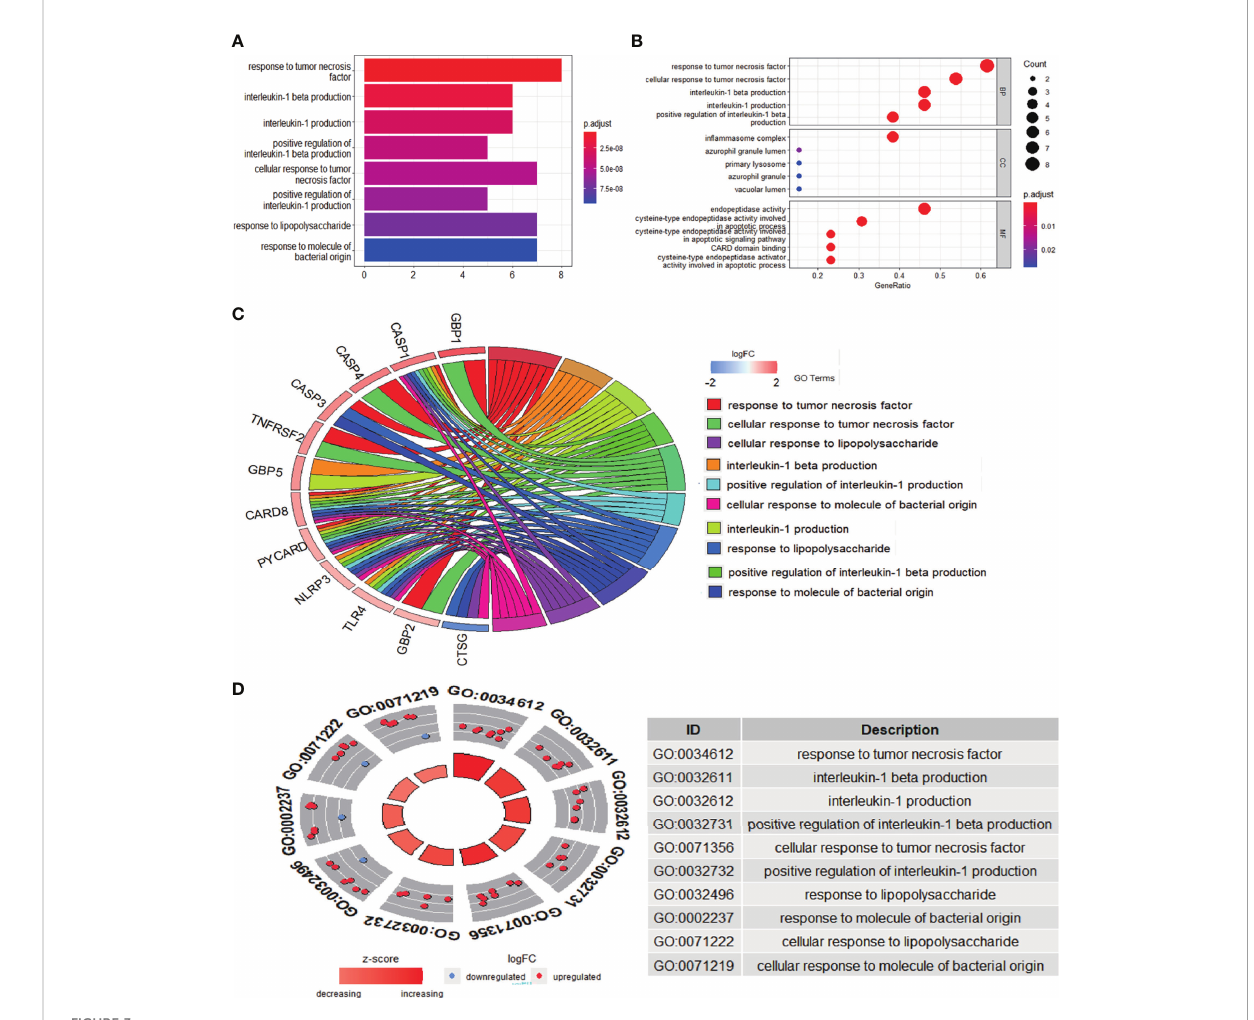
FIGURE 3 GO enrichment analysis of 13 differentially expressed PRGs. (A) Bar plot of enriched GO terms. (B) Bubble plot of enriched GO terms. (C) Chordal graph of enriched GO terms. (D) Eight diagrams of enriched GO terms. It contains three aspects — BPs, CCs, and MFs — and shows the speci fi c genes involved in each GO term. GO, Gene Ontology; PRGs, pyroptosis-related genes; BPs, biological processes; CCs, cellular components; MFs, molecular